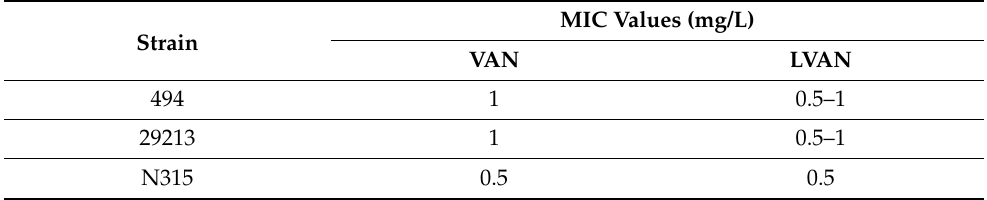
Table 1. MIC values of VAN and LVAN for strains 494 and 29213.